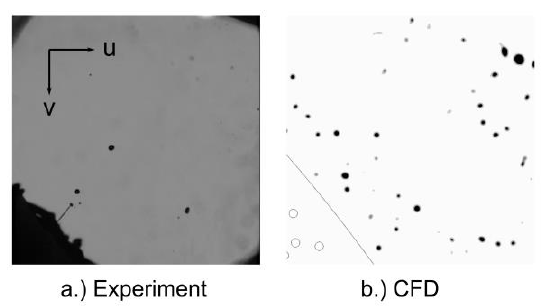
Fig. 5. Comparison of data obtained from experiment and CFD The size and velocity of the passing water particles were then analyzed in MATLAB® (PIVlab addon) from the obtained images. In the experimental images a 37 particles were recorded and in the CFD images a 347 particles were recorded. The diameters of recorded particles were analyzed and compared in a histogram according to size classes in 0.1 mm increments ( Figure 6) .